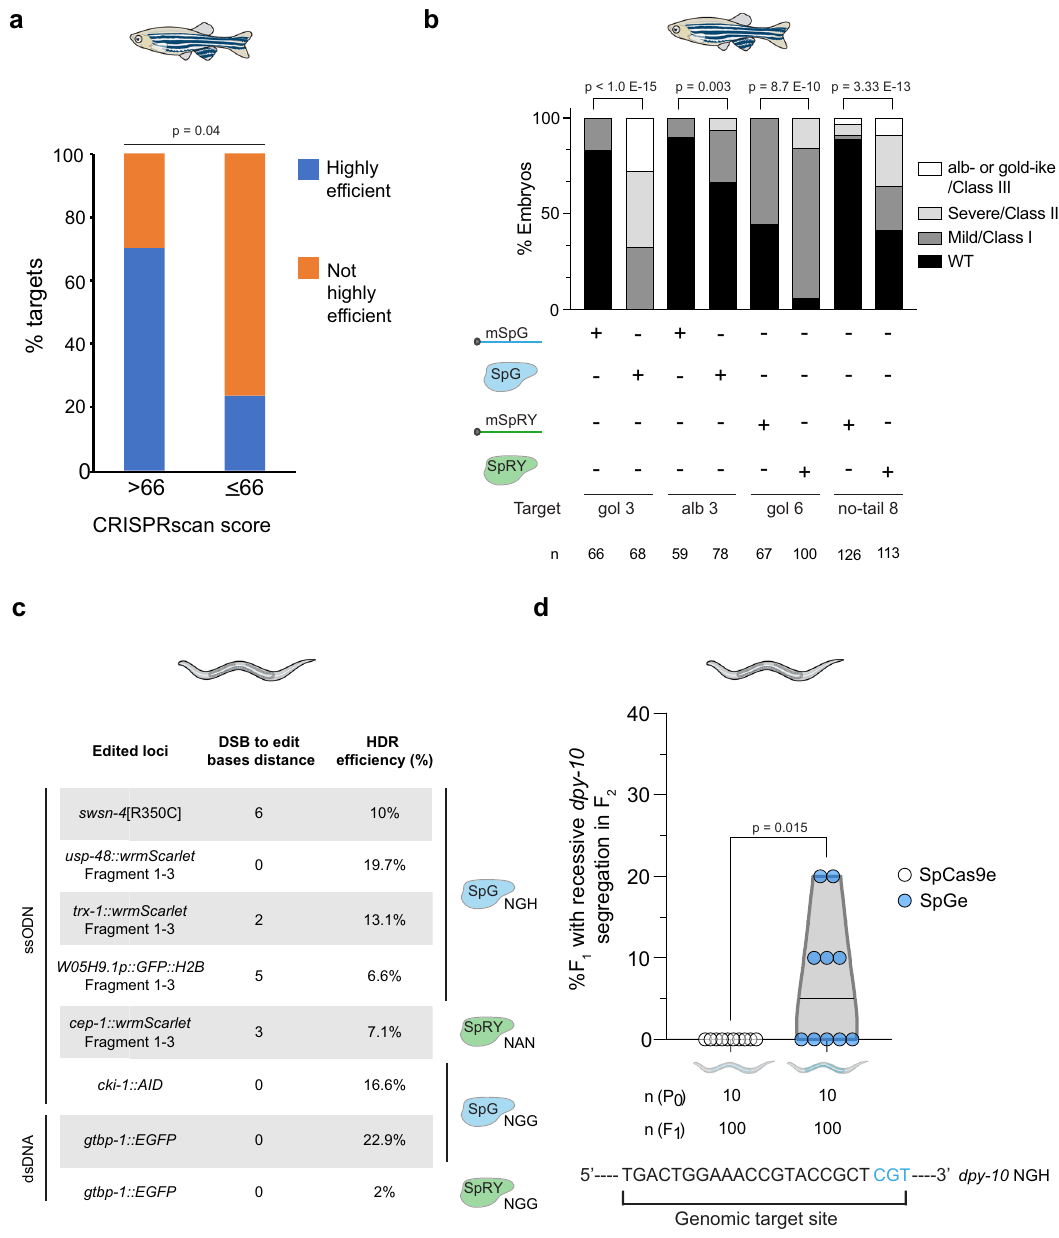
Fig. 4 Further SpG and SpRY optimization in vivo. a Prediction of gRNA activity in vivo using CRISPRscan. Stacked barplots show the percentage of highly ef fi cient gRNAs (blue) and not highly ef fi cient gRNAs (orange) in two groups separated based on CRISPRscan scores (>66 and ≤ 66). Highly ef fi cient gRNAs generate more than 50% of embryos with albino-like/golden-like/class III or severe/class II phenotypes and less than 10% phenotypically wild-type. Fisher test p value. b RNP can enhance SpG and SpRY activity in zebra fi sh. Stacked barplots show the percentage of albino- like/golden-like/class III, severe/class II, mild/class I, and phenotypically wild-type (WT) embryos 48 h post-fertilization (hpf) after injection. ( n ) total number of injected embryos. The results were obtained from at least two independent experiments. mSpG and mSpRY injections data from Fig. 2b, f, and RNP injections data from Supplementary Fig. 10. The χ 2-test p value per comparison is shown. c Utility of SpG and SpRY for the insertion of DNA sequences via HDR. We used ssDNA (ssODN) as a donor template to produce a missense mutation in swsn-4 , to introduce a gene fragment for nested CRISPR 19 at usp-48, trx-1 , W05H9.1, and to add a degron tag to cki-1 . Information about targeted sequences, PAMs, DSB to edit distance, insert lengths, nuclease concentration used, and correct vs incorrect insertions obtained, is showed in Supplementary Data 2. d EG9615 and CER660 worms, which express SpCas9 and SpG endogenously in the germline (SpCas9e and SpGe), respectively, were injected with tracrRNA and a crRNA targeting dpy-10 with an NGH PAM. The fl uorescent markers myo-2p::mCherry and myo-3p::mCherry were used as co-injection markers. F 1 worms expressing mCherry in the pharynx or body wall muscle were singled out and the appearance of Dpy progeny was screened in the F 2 . Editing ef fi ciency is de fi ned as the number of F 1 worms that segregate Dpy progeny in the F 2 divided by the total number of separated F 1 s. Each dot represents the editing ef fi ciency in each individual P 0 that produced at least ten mCherry-expressing F 1 s. All conditions were carried out in parallel injections (Student ’ s t test p